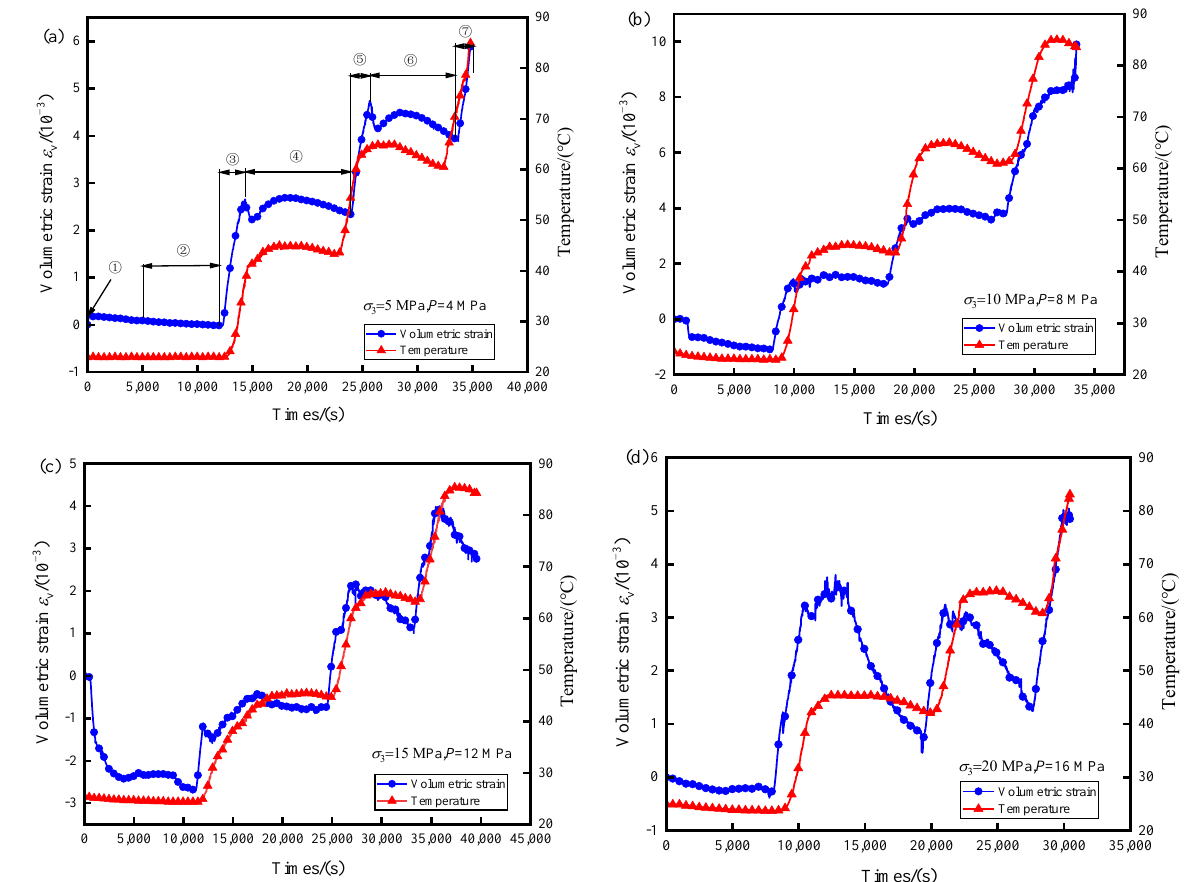
Figure 5. Volume–strain variation curve with temperature under different stress conditions with ( a ) σ 3 = 5 MPa, P = 4 MPa; ( b ) σ 3 = 10 MPa, P = 8 MPa; ( c ) σ 3 = 15 MPa, P = 12 MPa; ( d ) σ 3 = 20 MPa, P = 16